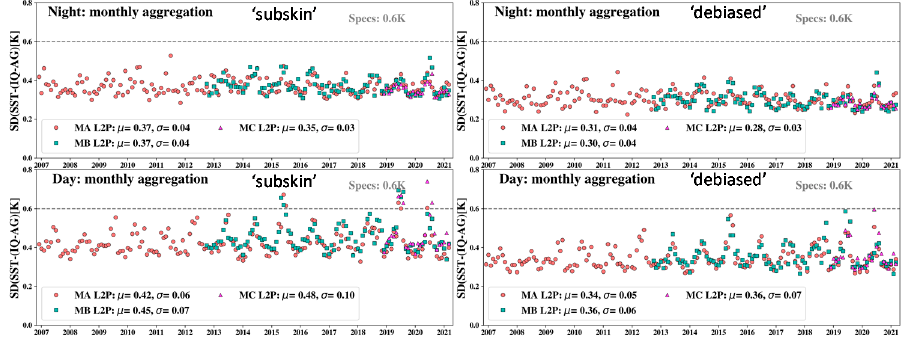
Figure 13. Same as in Figure 12, but for the global standard deviations (SDs).